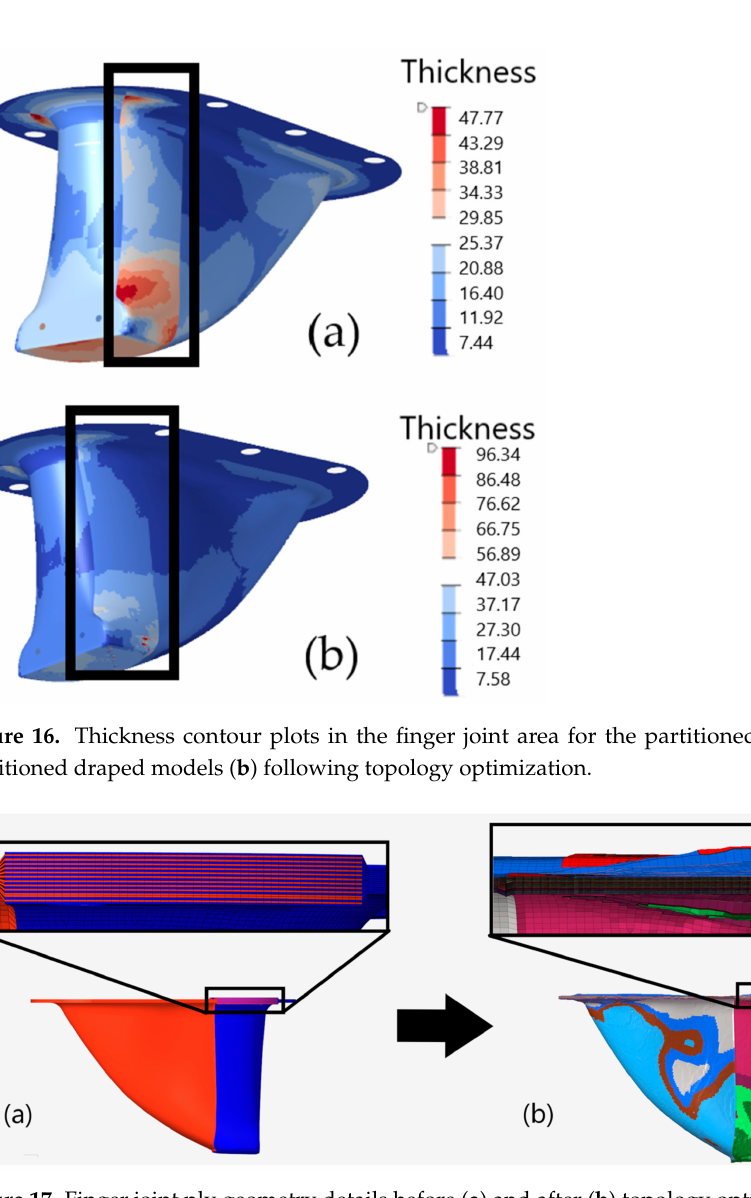
Figure 17. Finger joint ply geometry details before ( a ) and after ( b ) topology